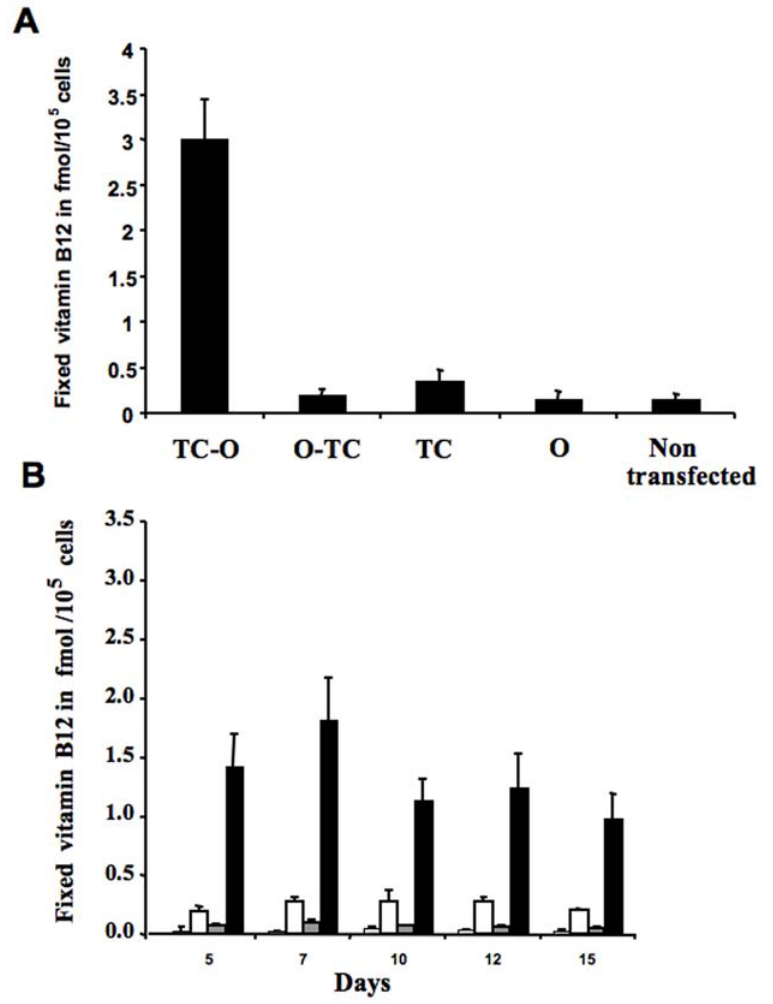
Figure 3. (A) Vitamin B12 binding capacity (cyano[ 57 Co]Cbl) of membrane fraction (100 m g proteins per assay) from Caco2 cells, 72 hrs after transient transfection with various recombinant pcDNA3 plasmids expressing transcobalamin (TC), oleosin (O) and the chimeric proteins transcobalamin-oleosin (TC-O) and oleosin-transcobalamin (O-TC). (B) Vitamin B12 ([57Co]-labeled) binding capacity of Caco2 cells of the intact and lyzed (Caco2 cells were lysed prior to the addition of vitamin B12 or used intact), at days 5–15 of culture, after stable transfection with a recombinant pcDNA3 plasmid expressing the chimeric protein transcobalamin-oleosin. Exponential and stationary phases were evaluated at days 5–7 and days 10–15, respectively. Bars from left to right for each time: non-transfected intact cells, non-transfected lysed cells, TC-O transfected intact cells, TC-O transfected lysed cells.